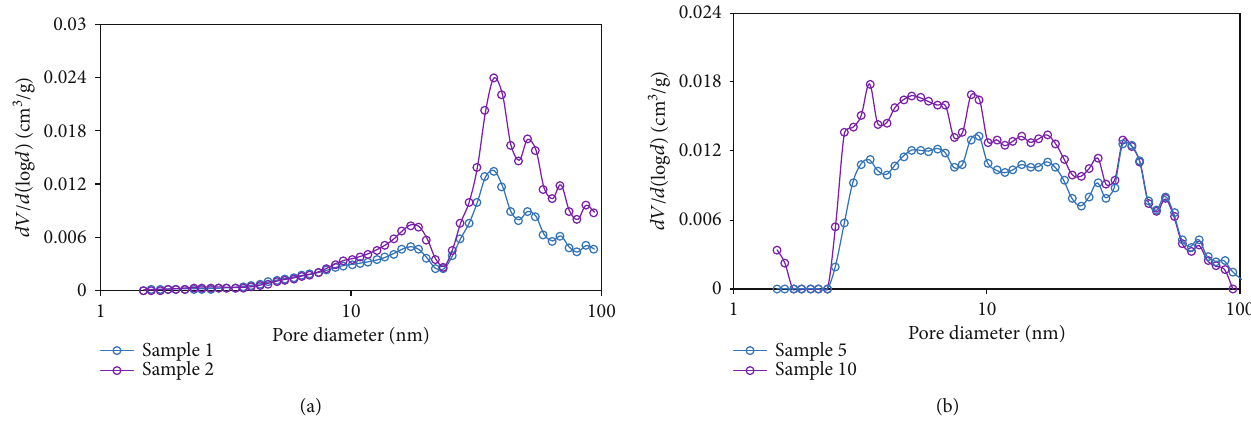
Figure 6: The pore size distributions of shale samples for K distributions of type B.